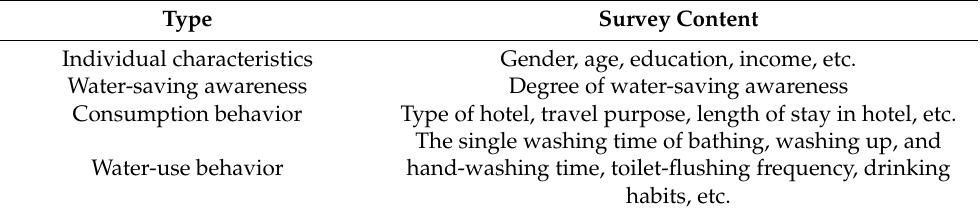
Table 1. Questionnaire content of hotel consumers’ water-use